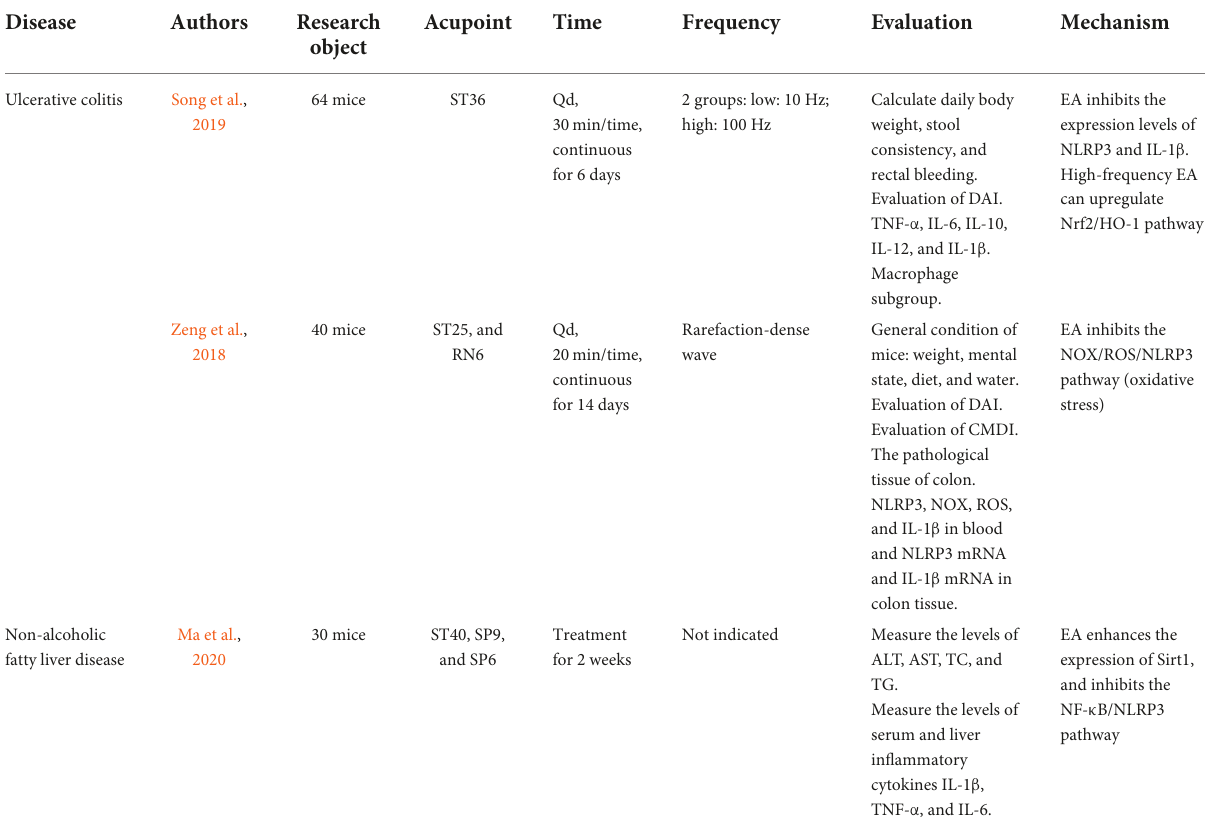
TABLE 1 Mechanism of electroacupuncture targeting NLRP3 inflammasome in the treatment of ulcerative colitis and non-alcoholic fatty liver disease.